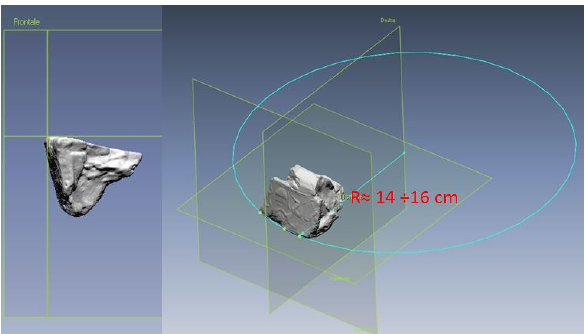
Figure 17. Orientation and estimated diameter of the fragment with Komòs scene.